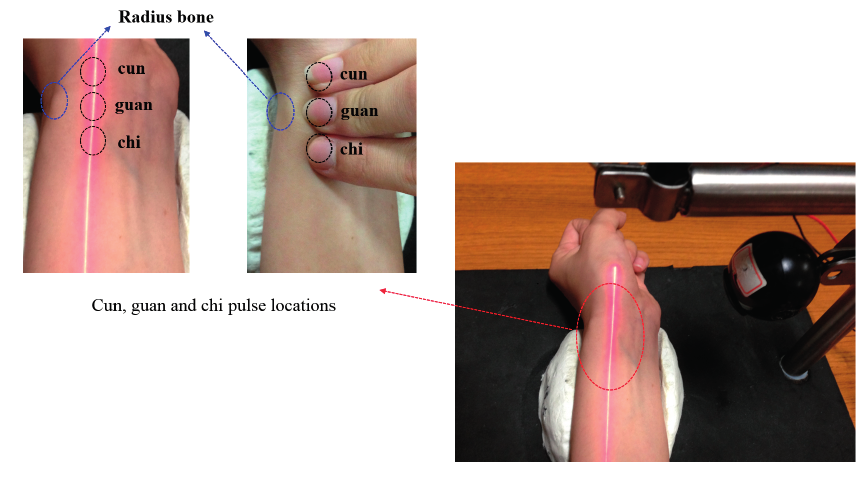
Figure 15. Measurement process.